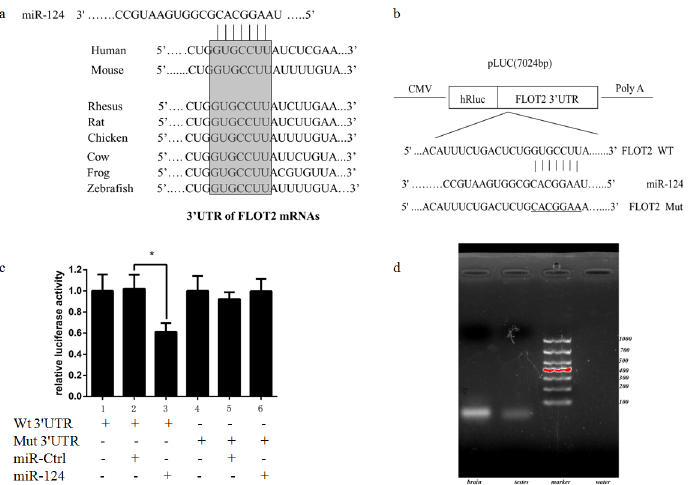
Fig 1. MiR-124 downregulates flotillin-2 expression by directly targeting its 3 0 -UTR in mouse testicular tissue. (a) Putative duplex formation between miR-214 and the flotillin-2 3 0 -UTR. The binding site is conserved between several mammalian species (in bold and boxed). (b) Assay constructs, wild-type and mutated target sequences of flotillin-2. (c) MiR-124 downregulated the luciferase activity of the flotillin-2 3 0 - UTR construct, whereas luciferase activity was not significantly decreased in the target region of the mutated mut 3 0 -UTR construct * p < 0.05 compared with control (two-tailed). Error bars indicate SD. (d) MiR-124 expression in mouse brain tissue and mouse testicular